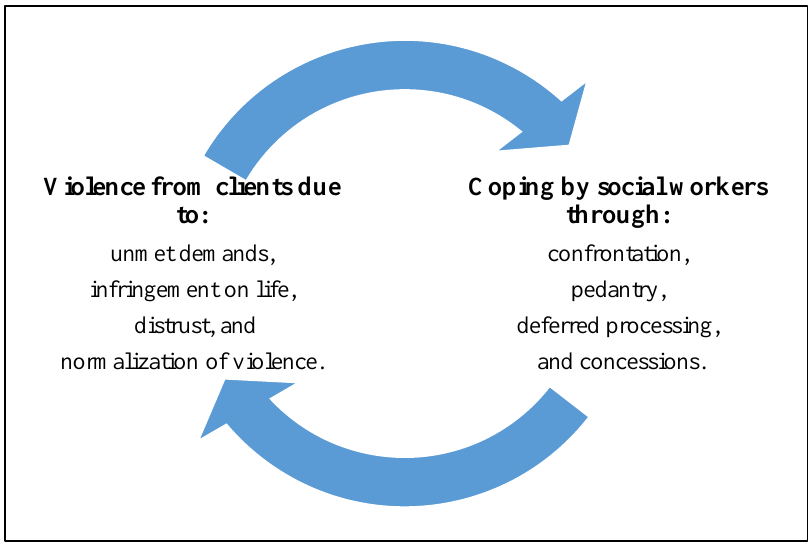
Figure 2. The cyclic relationship between client violence and social workers’ coping methods.